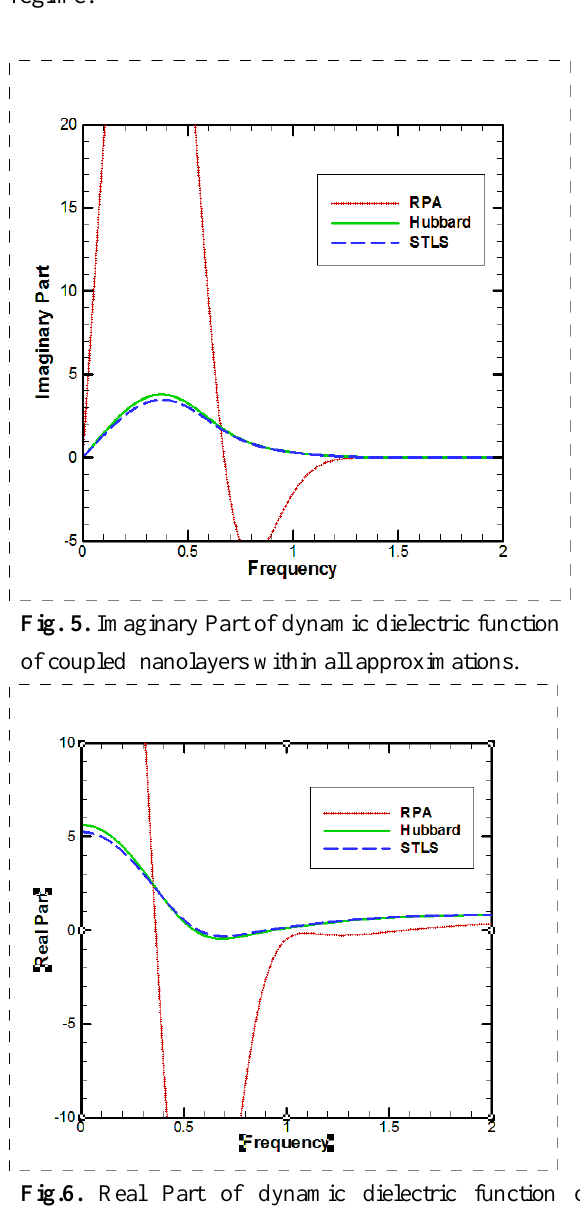
Fig.6. Real Part of dynamic dielectric function of coupled oupled